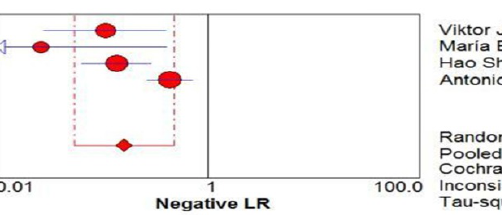
Figure 7. Forest plots of NLR of SF-BCB for PJI diagnosis